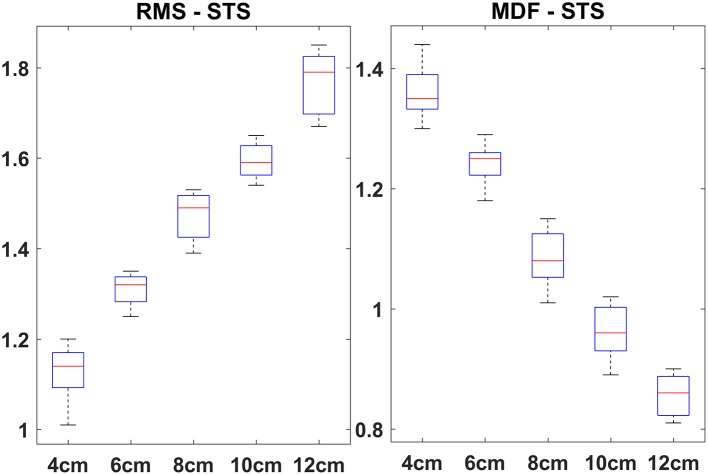
Onset time (mean ± SD) of VM and VL for different HHS.